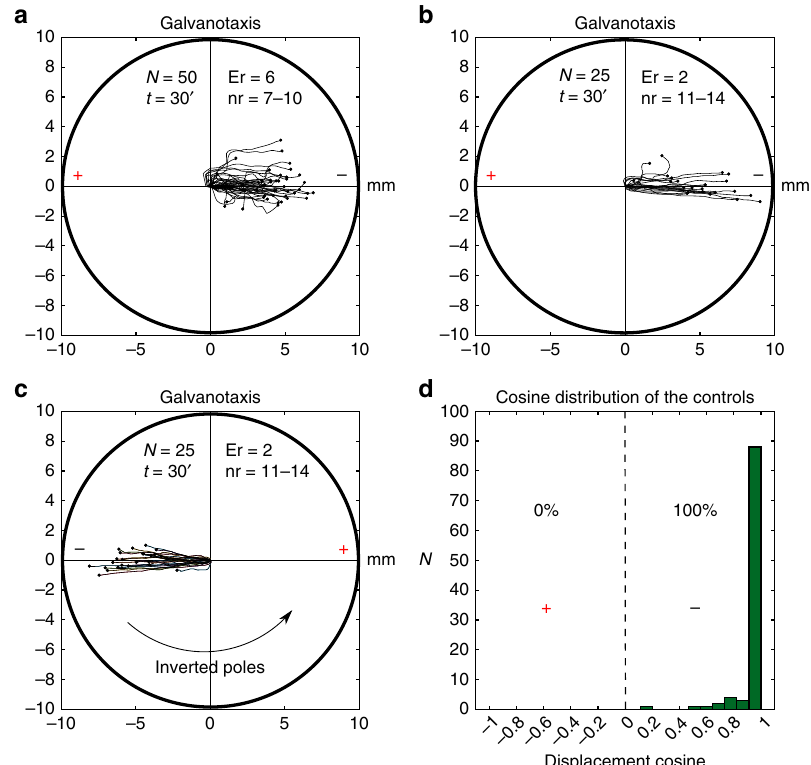
Fig. 6 Controls of galvanotactic behavior in Amoeba proteus . a 50 amoebae (experimental replicates: 6, number of cells per replicate: 7 – 10) were subjected to a controlled electric fi eld (galvanotaxis during 30 min) after being exposed to nFMLP peptide for at least 30 min. All cells exhibited normal galvanotaxis, that is, migration towards the cathode, con fi rming that exposure to nFMLP was not able to elicit changes in the normal galvanotactic response of Amoeba proteus by itself. b 25 amoebae (experimental replicates: 2, number of cells per replicate: 11 – 14) were subjected to a galvanotactic stimulus during 30 min, next, the cells were placed in a Petri dish fi lled with Chalkley ’ s medium for 3 min and then exposed to another identical electric fi eld with inverted polarity c (experimental replicates: 2, number of cells per replicate: 11 – 14). All the amoebae showed a normal galvanotactic behavior in both occasions b , c . d Distribution of the cosines of displacement angles for all the trajectories under galvanotaxis ( a , b and c ). In order to represent the preference towards a pole for the three controls simultaneously, the signs of the cosines of displacement angles of the trajectories represented in panel c were inverted (associating the anode to negative cosines and the cathode to positive values). As it was observed previously in Fig. 3e, 100% of the displacement cosines were positive, indicating a strong preference towards the cathode when the electric fi eld was active. “ N ” total number of cells, “ Er ” experimental replicates, “ nr ” number of cells per replicate, “ t ” galvanotaxis time, “ + ” anode, “ − ” cathode. Both the x and y axis show the distance in mm, and the initial location of each cell has been placed at the center of the